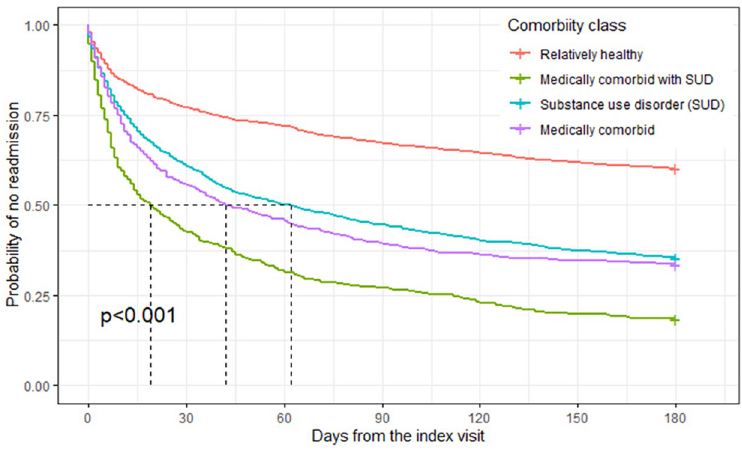
Fig 2. Kaplan-Meir curves of probability of no readmission against time (in days) since the